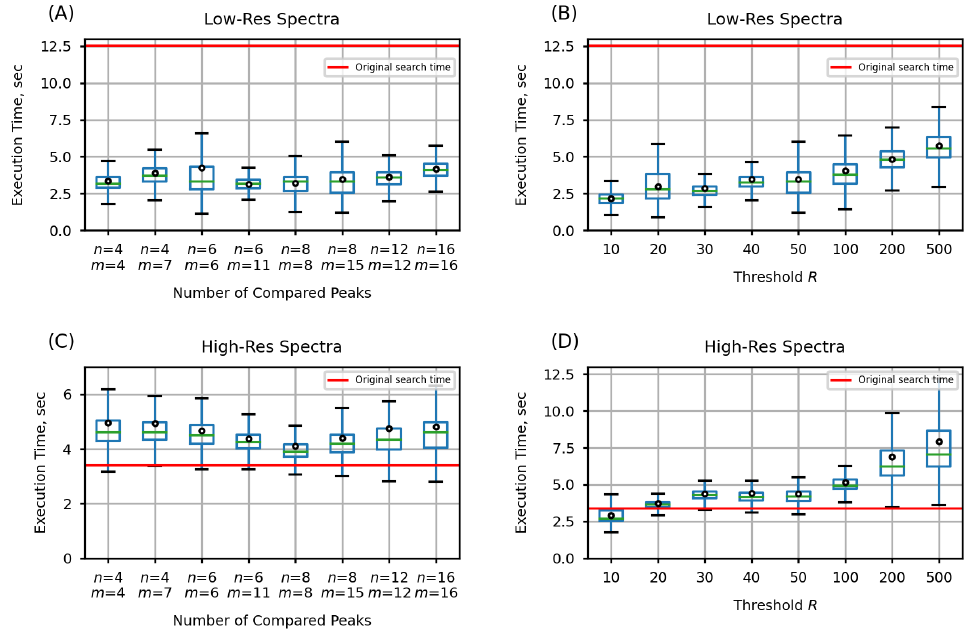
Figure 2. Execution times of the new search algorithm, estimated for prescreening parameters ( n , m , R ) , where n is the number of query spectrum peaks participating in the prescreening search, m the number of library spectrum peaks participating in the prescreening search, and R determines the number of candidate spectra returned by the prescreening search: ( A , B ) search against low-resolution spectra; ( C , D ) search against high-resolution